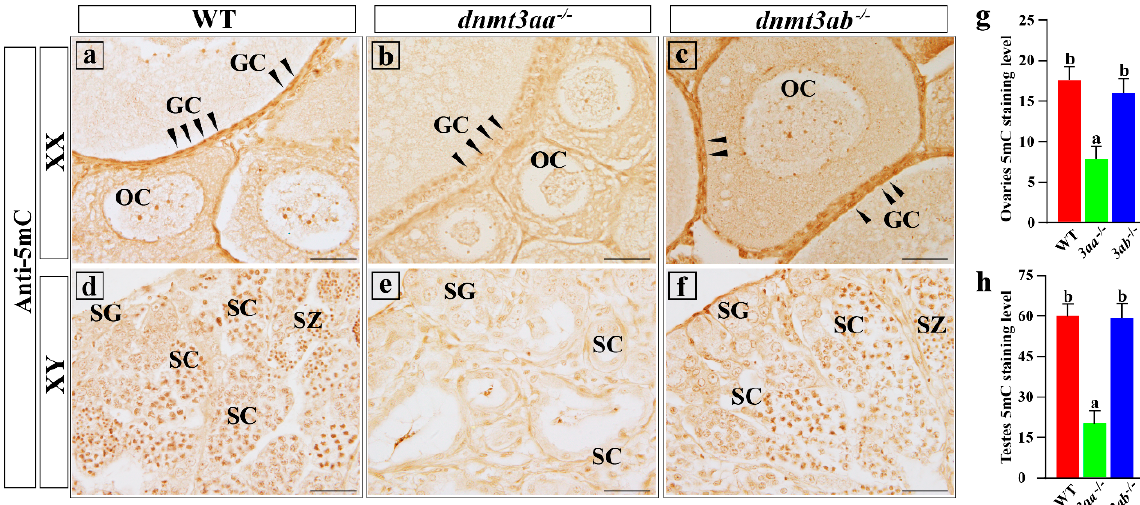
Figure 9. 5-methylcytosine (5-mC) staining of WT, dnmt3aa − / − and dnmt3ab − / − gonads at 120 dah. ( a – c ) 5-mC staining of WT, dnmt3aa − / − and dnmt3ab − / − ovaries. Positive signals were observed in the nuclei of oocytes and granulosa cells. ( d – f ) 5-mC staining of WT, dnmt3aa − / − and dnmt3ab − / − testes. Positive signals were observed in spermatogonia, spermatocytes and spermatozoa. The positive signals correspond to the brownish color. ( g ) Statistical analysis of relative 5-mC staining level in WT, dnmt3aa − / − and dnmt3ab − / − ovaries. ( h ) Statistical analysis of relative 5-mC staining level in WT, dnmt3aa − / − and dnmt3ab − / − testes ( n = 5, and five sections were counted per sample). The IHC positive signals were quantified using image J software according to the instructions. Results are presented as mean ± SD. Different letters above the error bar indicate statistical differences at p < 0.05 as determined by one-way ANOVA followed by Tukey’s post hoc test. OC, oocytes; GC, granulosa cells; SC, spermatocytes; SG, spermatogonia; SZ, spermatozoa. Scale bar, 10 μ m. The black arrow indicated 5-mC-positive signals in granulosa